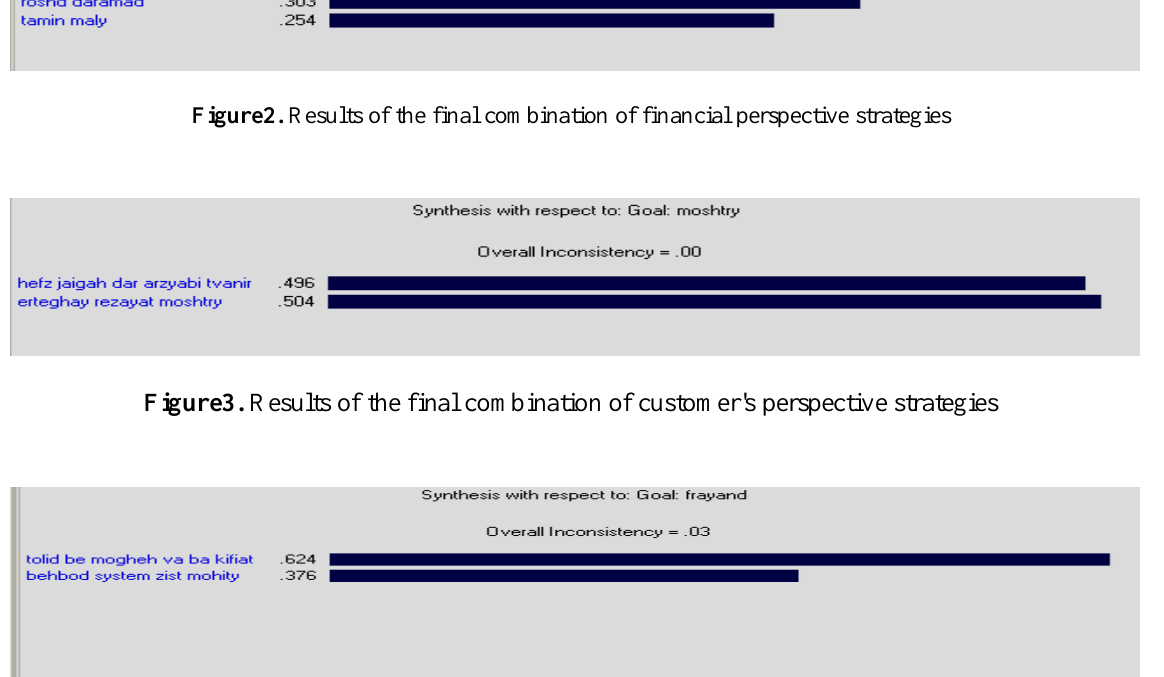
Figure4. Results of the final combination of internal process perspective